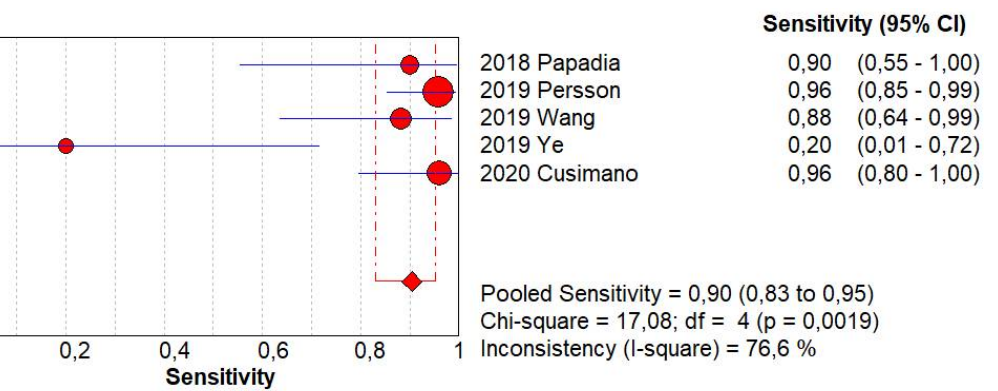
Figure 2. Forest plots of individual studies and pooled false negative rate of sentinel lymph node biopsy in detecting endometrial carcinoma metastasis. DRh was 88.4% (95% CI: 86–90.5%; I 2 : 20.1%; Figure 3), DRp was 96.6% (95% CI: 94.7– 97.8%; I 2 : 0%%; Figure 4), and DRb was 80% (95% CI: 75.4–83.9; I 2 : 28.9%; Figure 5). Detection rates were calculated without considering ICG reinjection since only one study performed it [30].